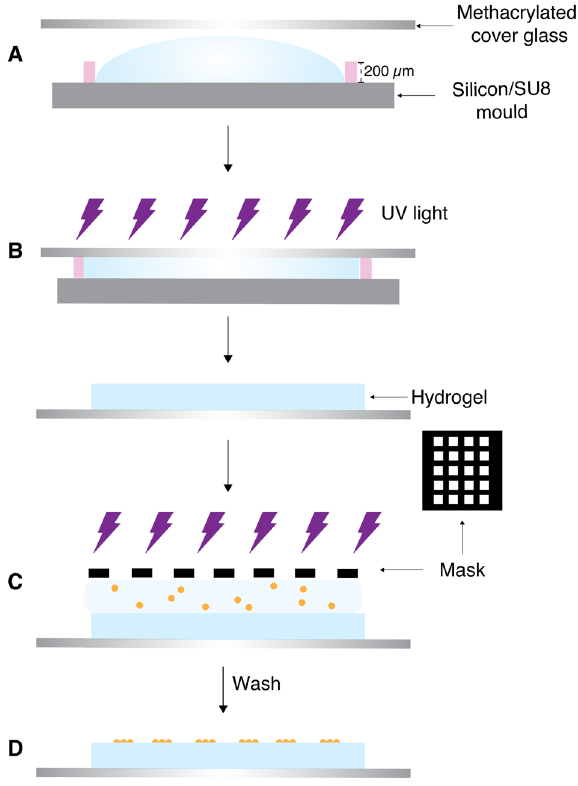
Fig. 2 Schematic of HA-am hydrogel formation and patterning with RGD peptides. A Hydrogel precursor solution (HA-am 2% (w/v)) and photo-initiator (Irgacure 2959 0.4% in DPBS) was placed in the Si/ SU8 mould and covered by a methacrylate-functionalized cover glass. B UV exposure. C RGD-peptide solution was pipetted on top of the gel, covered with a photomask and then exposed to UV light. D Unreacted peptides were removed by a washing step with